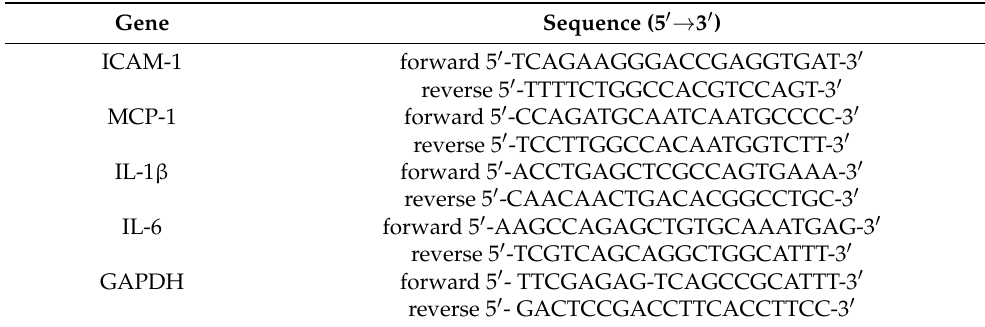
Table 2. List of PCR primers.